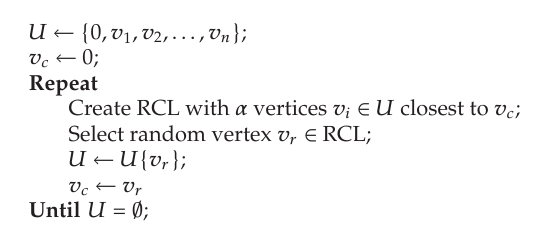
Algorithm 1: Outline of the GRASP for the